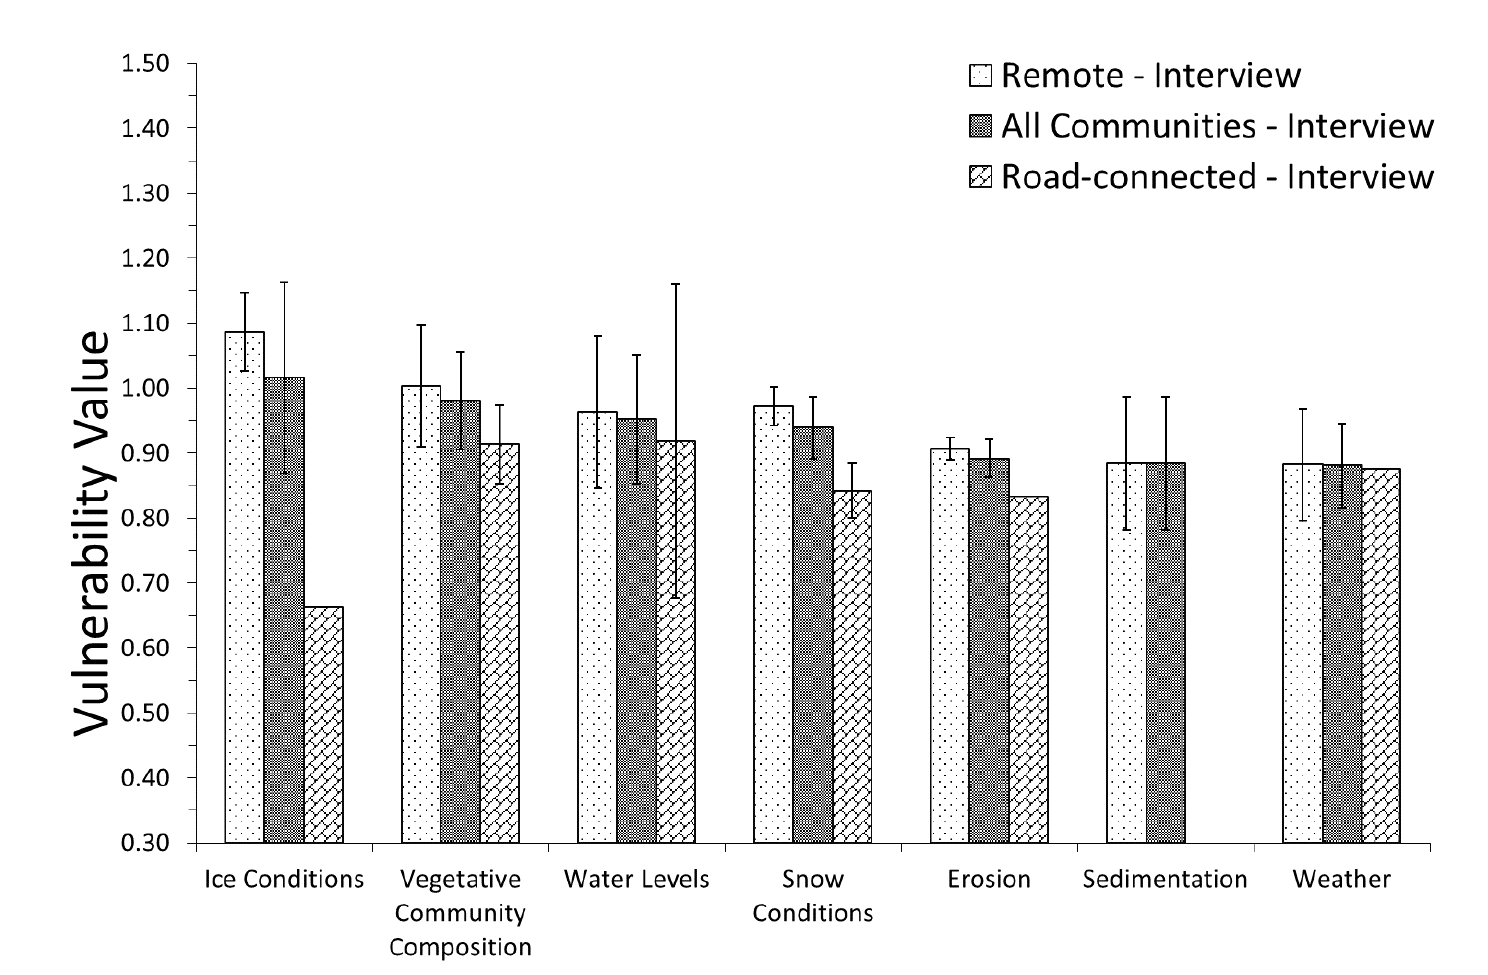
Figure A3.2. Graph comparing vulnerability values and associated margins of error for environmental conditions from interview data among remote communities, road-connected communities and all communities